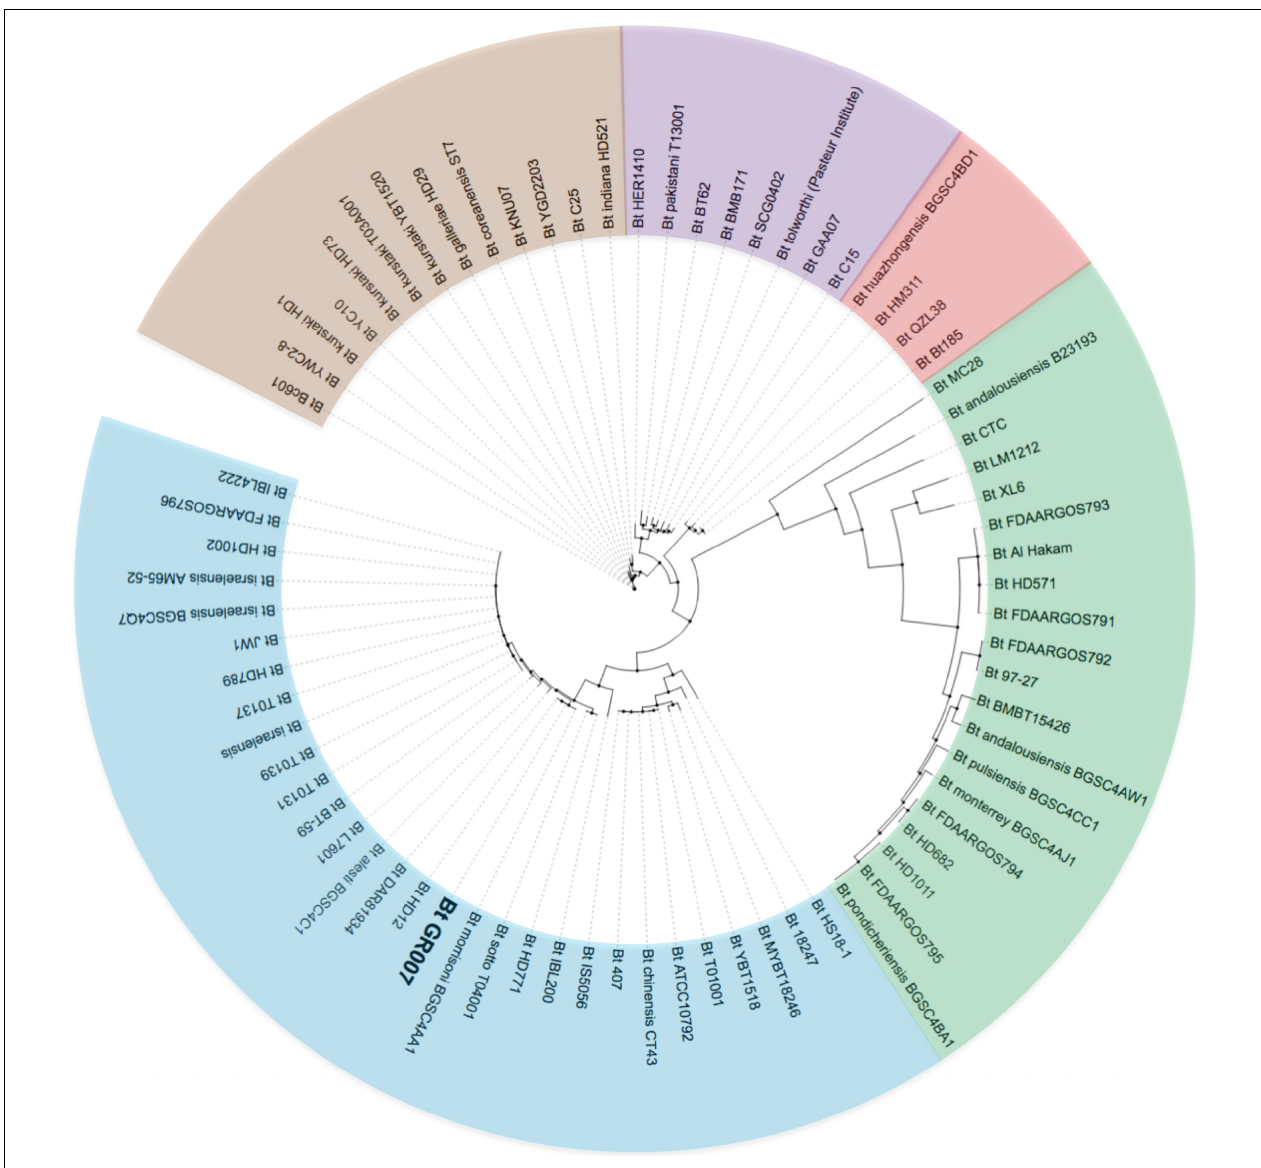
FIGURE 2 | Unrooted phylogenomic tree based on SNP of core genomes of GR007 and other 73 B. thuringiensis strains from NCBI that were reported as assembled genomes. Clades are represented with blue, green, red, purple, and brown colors.